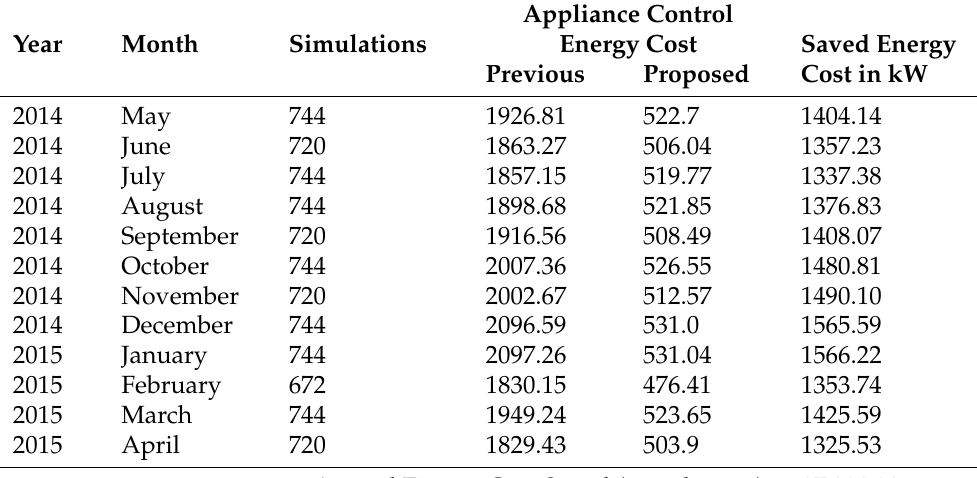
Table 11. Month-wise energy-cost comparison for dataset